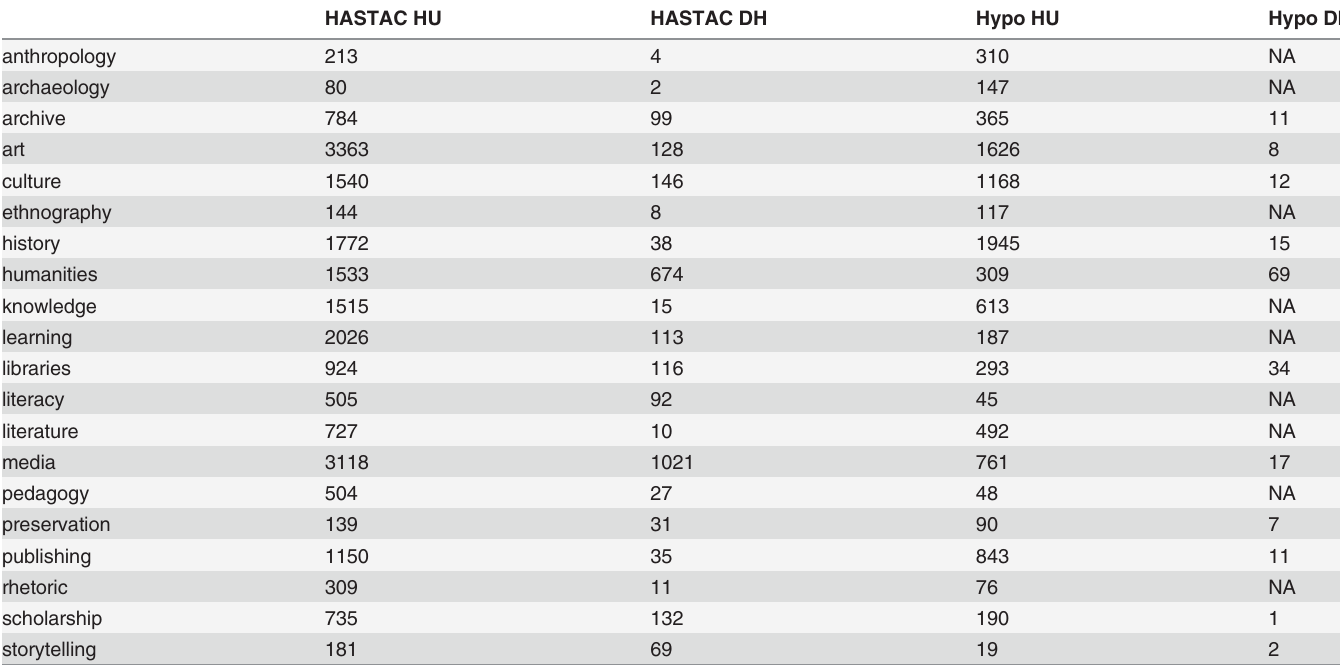
Table 1. Number of occurrences of humanities and DH